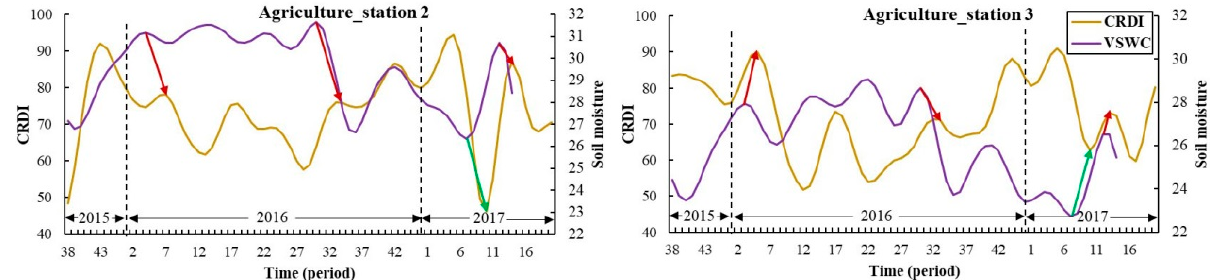
Figure 8. The indexes of CRDI and VSWC of agriculture at different geographical locations. The red arrow represents the lag of the peak, and the green arrow represents the lag of the valley. The dotted line represents the division of